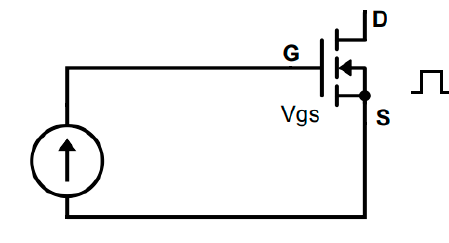
Figure 10. Calibration electrical circuit for V gs.